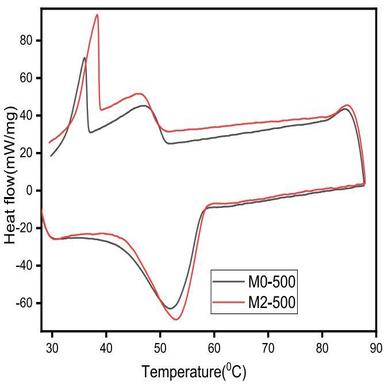
DSC curve of PW-PA, PW-PA-0.5% TiO2 after 500 thermal cycles.